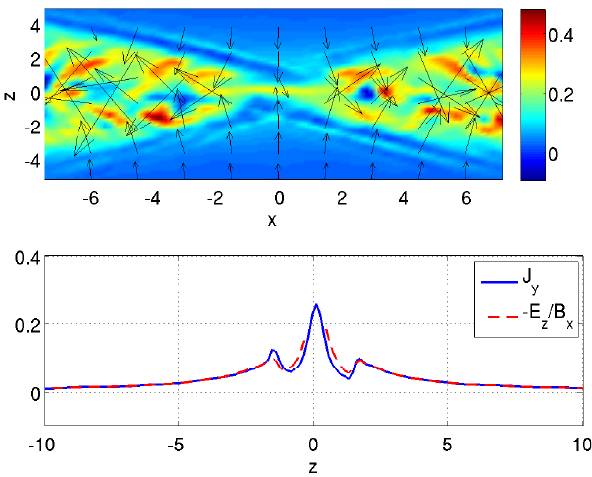
Fig. 4. Top panel: current density J y , shown by the colour, and in- plane electric field vectors ( E x ,E z ) by the arrows at t = 145. Bot- tom panel: cuts of J y and − E z /B x (points near z = 0 excluded as B x = 0 at z = 0) along x =